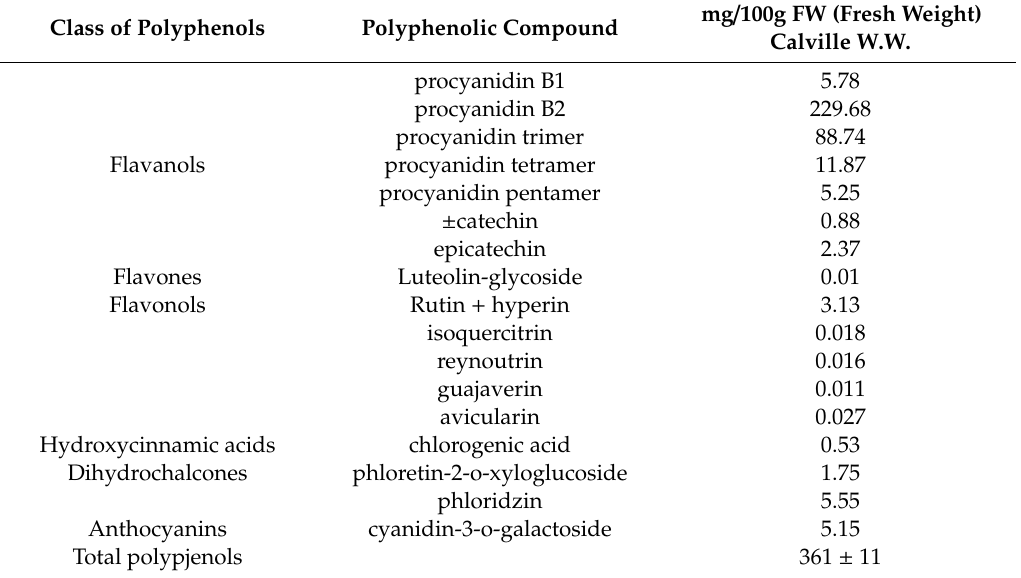
Table 1. Polyphenolic compounds in Calville W.W . apple. Data are expressed as mean value (mg / 100 g fresh weight) ( n =